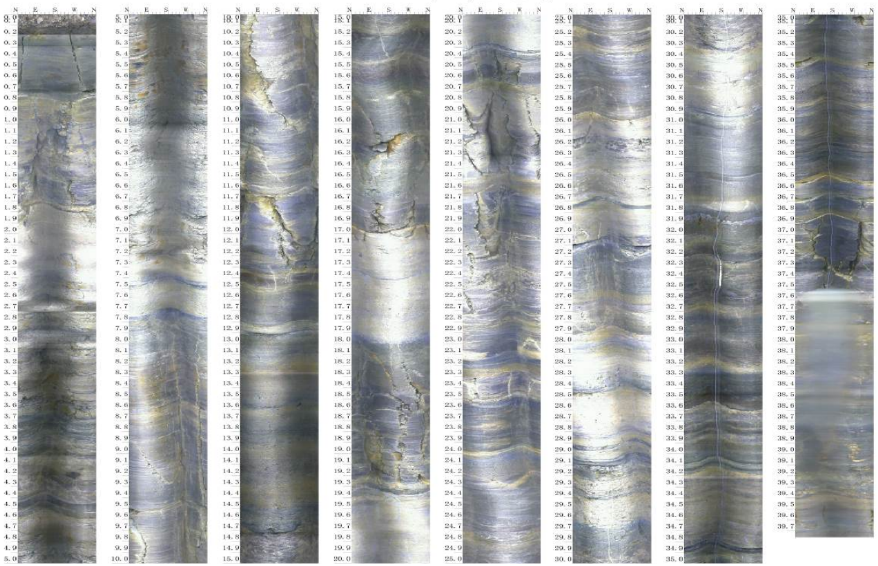
Figure 2. Drilling TV results (The yellow bands are mudstone